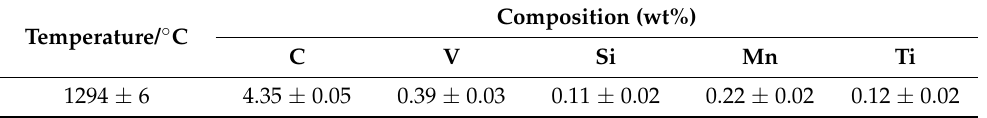
Table 1. Original compositions and temperatures of molten iron.